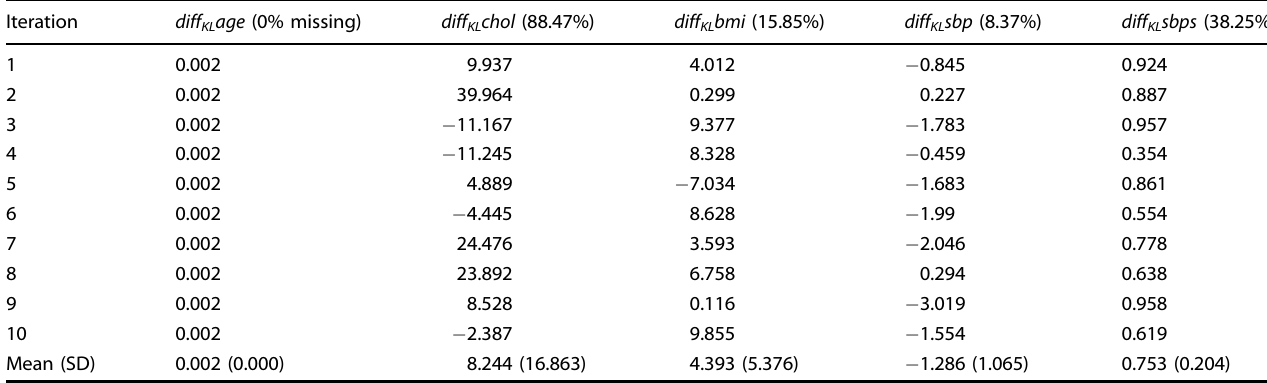
Table 4. KL divergence differences between resampled data sets and synthetic data sets for each variable and associated missing rate in parentheses.